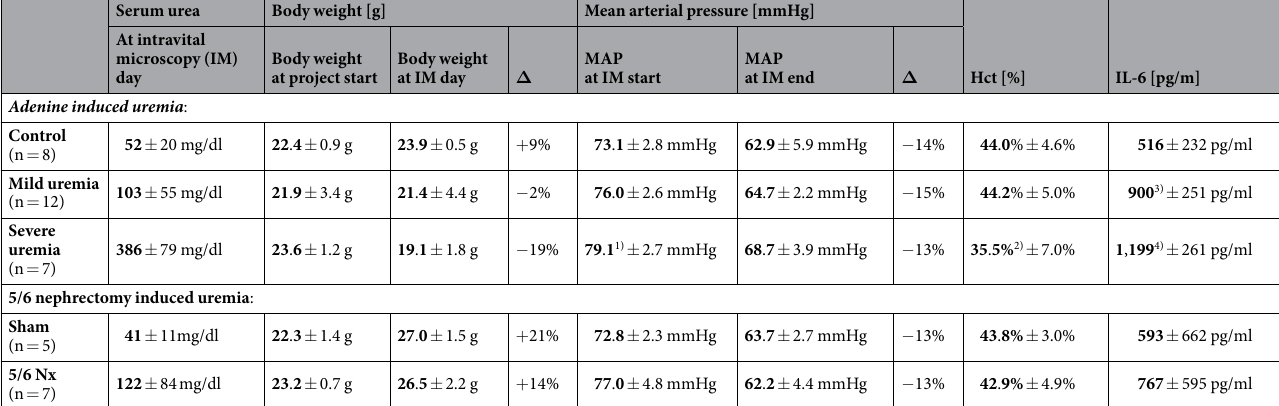
Table 1. Characteristics of experimental groups. 1) p = 0.005 compared to controls. 2) p = 0.015 compared